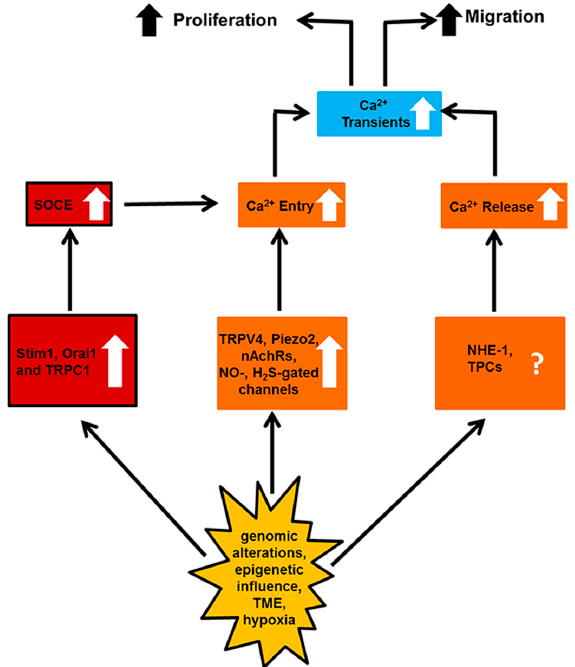
Figure 1. The endothelial Ca 2+ transportome is remodeled to sustain tumor vascularization. The sequence of events is illustrated by the black arrows. Upward arrows indicate the over-expression of a specific Ca 2+ -permeable channel or transporter and the stimulation of a precise cellular process. See the text for further details.